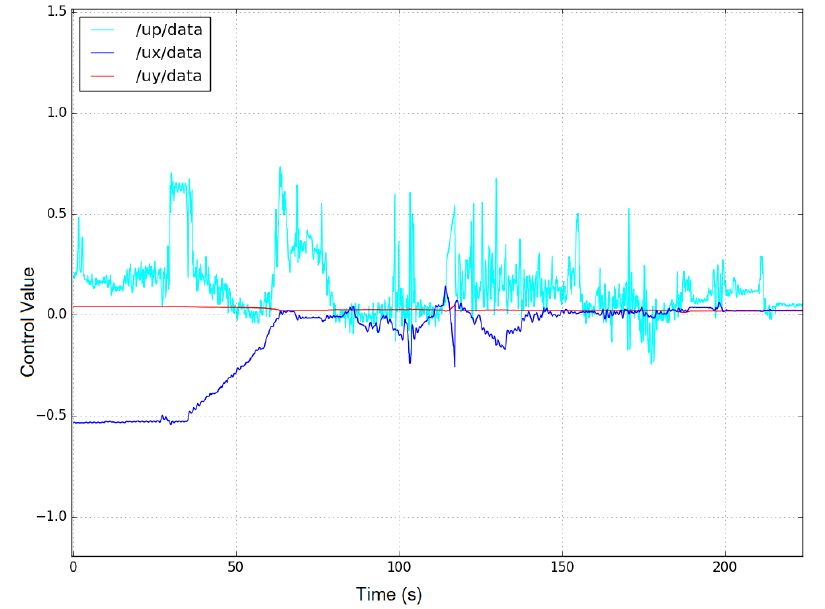
Figure 16. 3-axis control signals for the BlueROV follower-1 robot. (The blue, red, and light blue line represent the control signal on the x-axis and y-axis and the corresponding angle control signal,